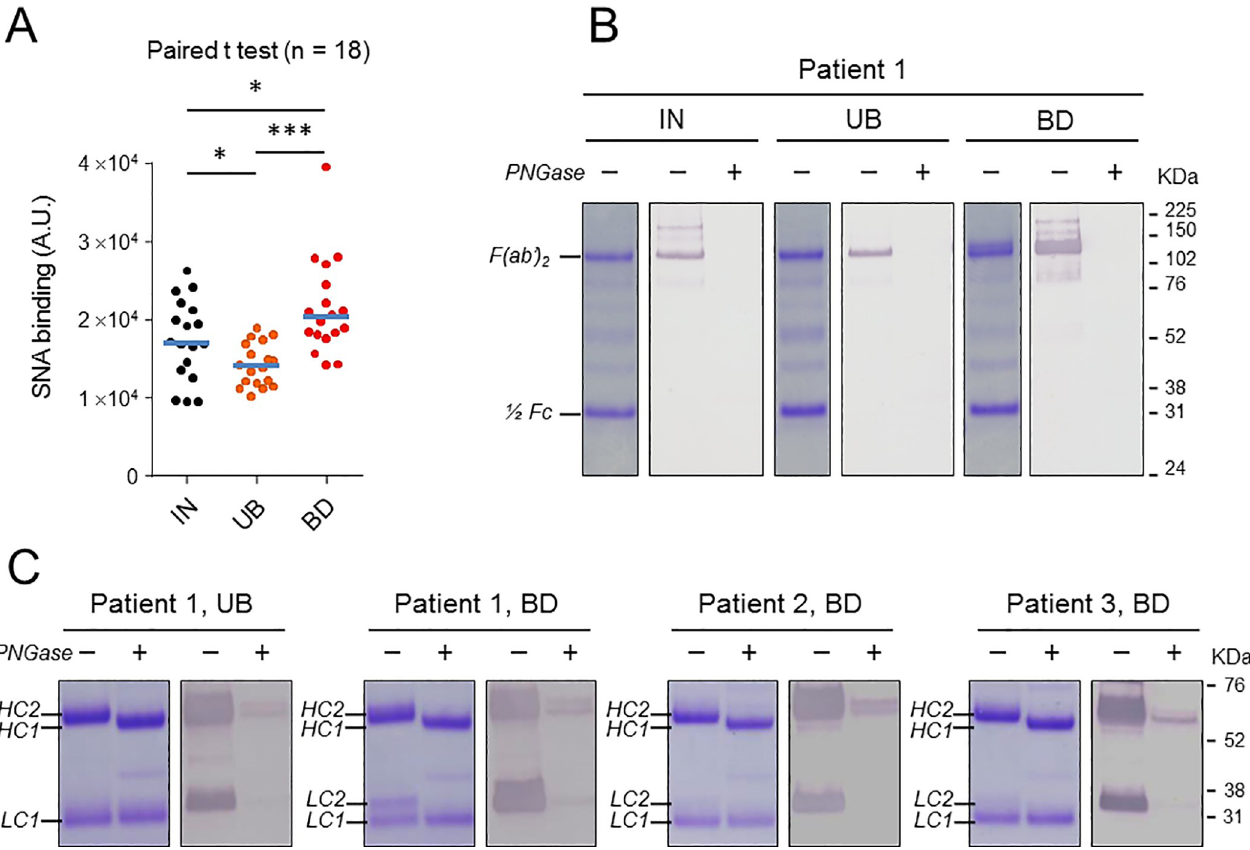
Fig 5. Sialic acid content of anti-MPO enriched IgGs relative to unfractionated material. Scheme of the affinity pull-down assay as in Fig 4. IN: sample before fractionation, UB: unbound fraction (anti-MPO depleted IgG), BD: bound fraction (anti-MPO enriched IgG). A: Determination of sialic content of IgG pull-down fractions by enzyme-linked lectin assay (ELLA). Median values are indicated by blue horizontal bars. Statistical differences were analyzed using a paired Student’s t test. ��� : p < 0.001, � : p < 0.1. B: Digestion of pull-down fractions with IdeS protease produces F(ab’) 2 and Fc fragments that were separated by SDS-PAGE under non-reducing conditions and detected by Coomassie blue staining. Sialic acid content of IdeS digestion products was evaluated by lectin blot analyses. C: Incubation of IgG pull-down fractions with reducing agent DTT results in dissociation of heavy and light chains that were separated by SDS-PAGE, detected by Coomassie blue staining, and evaluated for sialic content by lectin blots. LC: light chain, HC: heavy chain. Note the double band in Patient 1, BD sample, of which mainly the upper one (LC2 band) is visualized by SNA lectin. The two other samples (Patients 2 and 3) exhibited only one light chain and one heavy chain band following Coomassie blue staining. All samples in panels B and C were treated with (+) or without (-) PNGase-F prior to separation on SDS-PAGE. Removal of N- glycans by PNGase F treatment reduced SNA binding.